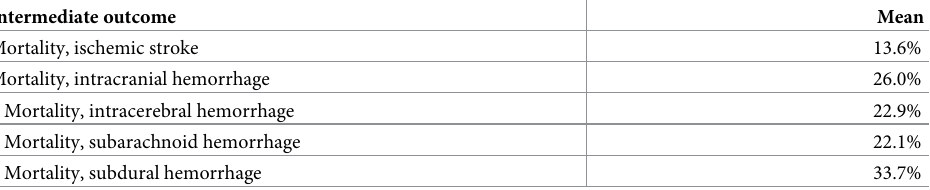
Table 4. Intermediate results: In-hospital mortality, by